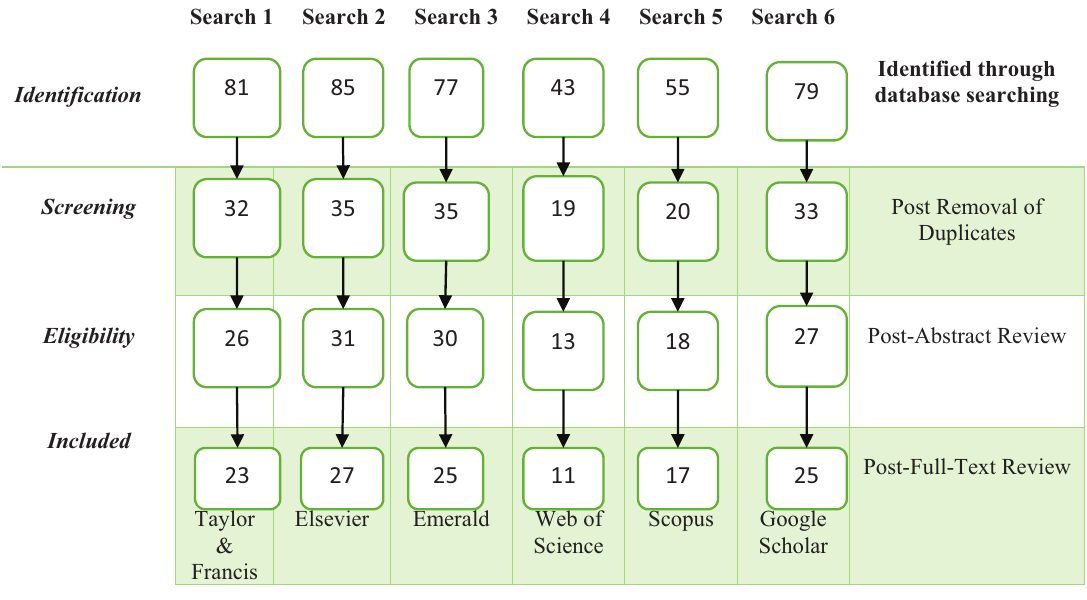
Figure 2. Overview of paper identification, selection, and inclusion